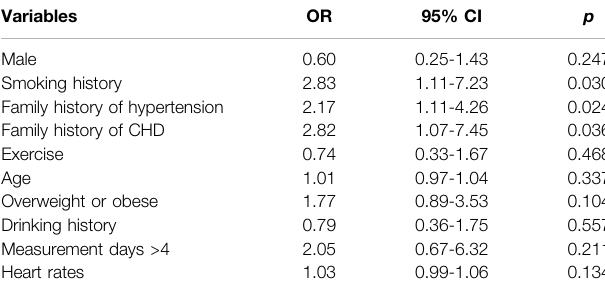
TABLE 3 | Multivariate logistic regression analysis for related factors in Masked hypertension.